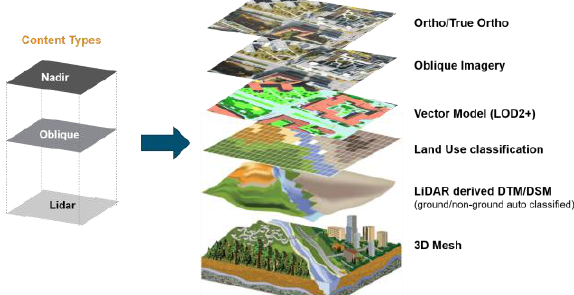
Figure 9: (Standard) Products to be produced from hybrid sensor